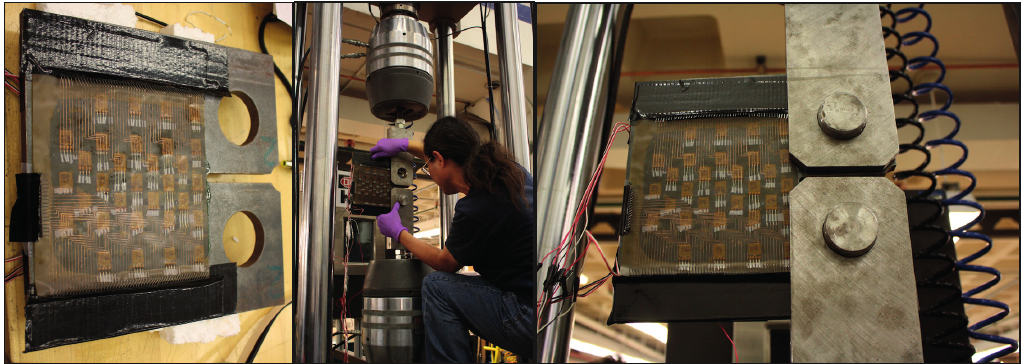
Figure 11. ( Left ): protection of sensing sheet connectors with insulation tape; ( Middle ): steel plate is placed into the fixtures; ( Right ): steel plates are fastened tightly with two steel pins.